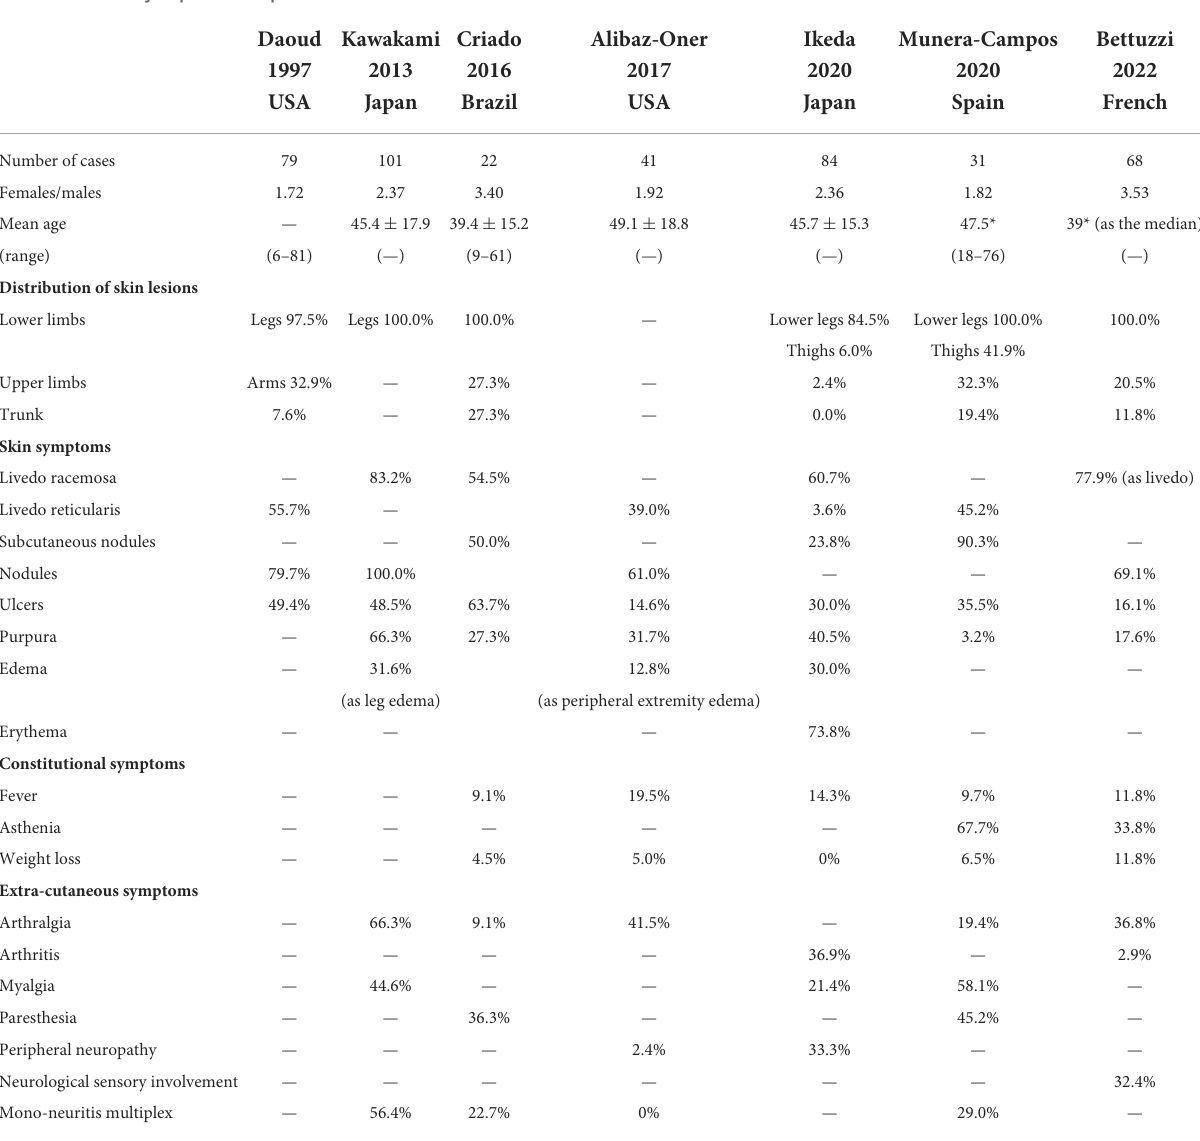
TABLE 1 Summary of previous reports on clinical